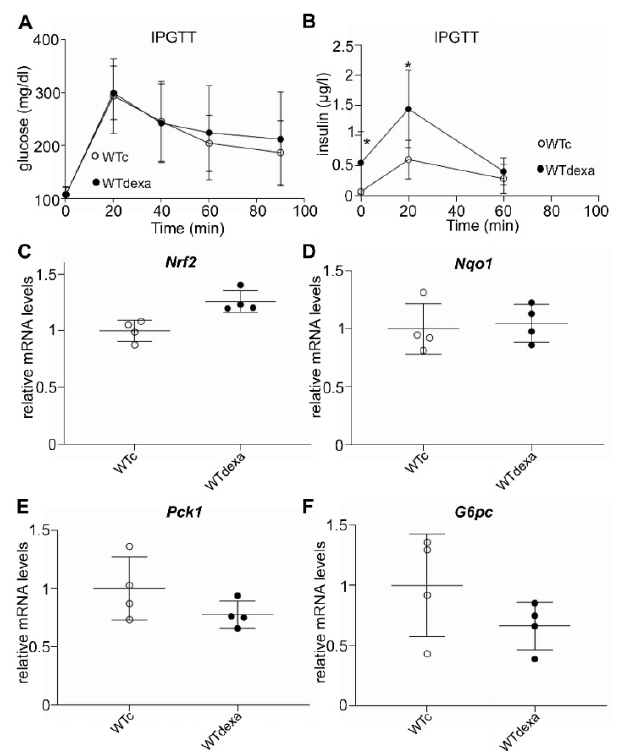
Figure 7. Intraperitoneal glucose tolerance test (IPGTT) ( A ) and measurement of insulin levels at certain timepoints during the test ( B ) in WT mice treated short term (2 consecutive days) with vehicle or dexamethasone. Relative mRNA expression of Nrf2 ( C ), Nqo1 ( D ), Pck1 ( E ), and G6pc ( F ) in livers of WT mice treated short term with vehicle or dexamethasone. * p < 0.05 compared to vehicle-treated. WTc: wild-type control (vehicle-treated); WTdexa: wild-type